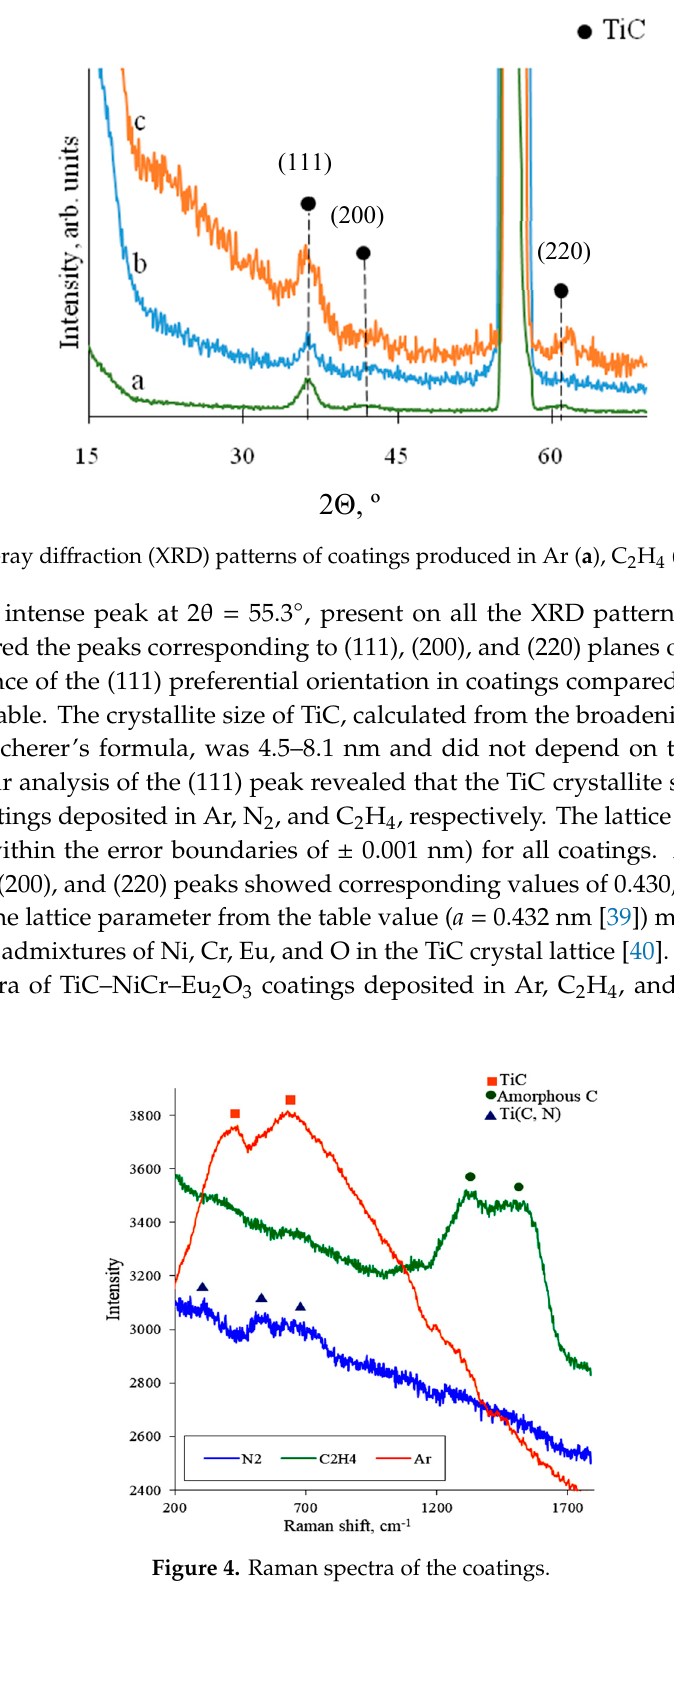
Figure 4. Raman spectra of the coatings.